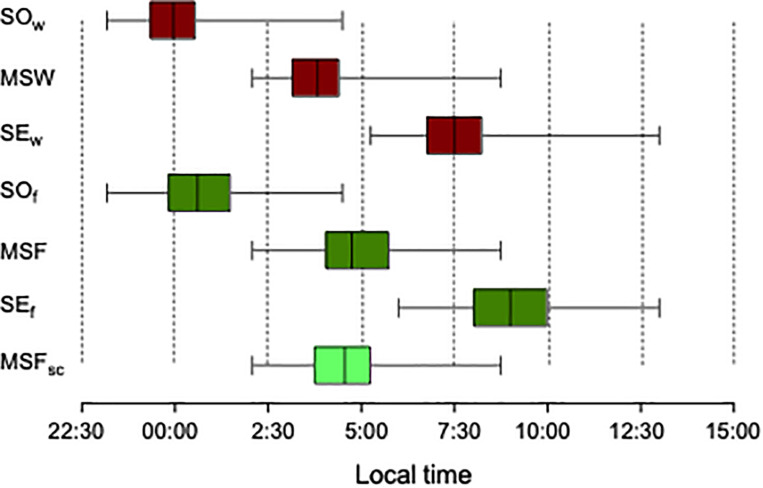
Timing of sleep–wake behavior on workdays (red) and work-free days (green) derived from the MCTQ. The bottom brighter green box represents MSFsc. Sample size n = 80, except for MSFsc with n = 62. SOw, Sleep onset on workdays; MSW, Mid-sleep point on workdays; SEw, Sleep End on workdays; SOf, Sleep onset on free days; MSF, Mid-sleep point on free days; SEf, Sleep end on free days; MSFsc, Sleep-corrected mid-sleep on free days.